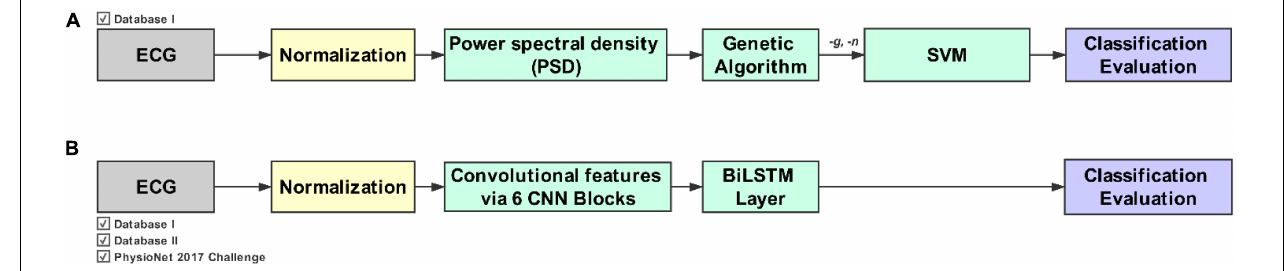
FIGURE 1 | Workflow for the evolutionary neural system approach (Method I) and the deep learning approach (Method II). (A) Method I combines the genetic algorithm (GA) with the support vector machine (SVM). (B) Method II combines the convolution neural network (CNN) with the bidirectional long short-term memory (BiLSTM) network. Note that Method I requires a feature extraction phase in addition to the GA and SVM.